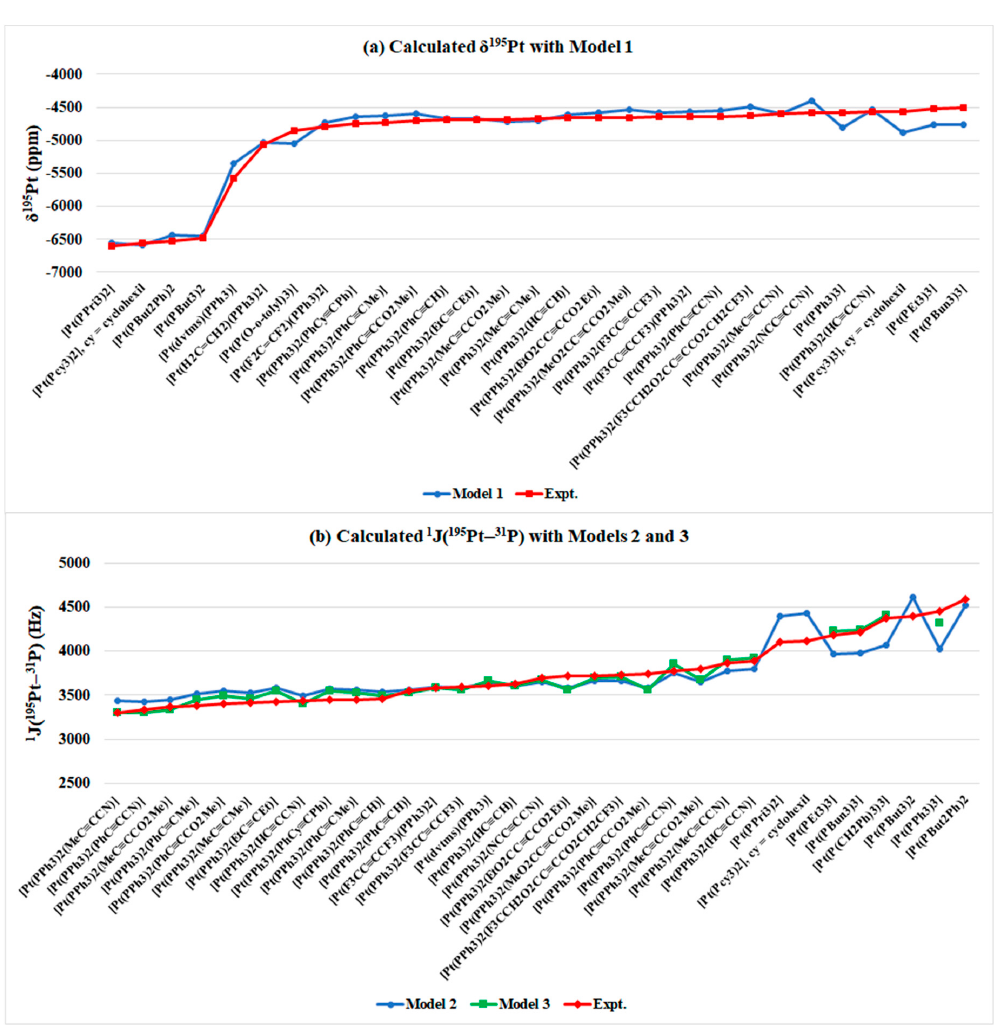
Figure 2. Relation between calculated and experimental: ( a ) δ 195 Pt (ppm) – Model 1; ( b ) 1 J( 195 Pt– 31 P)—Models 2 and 3.